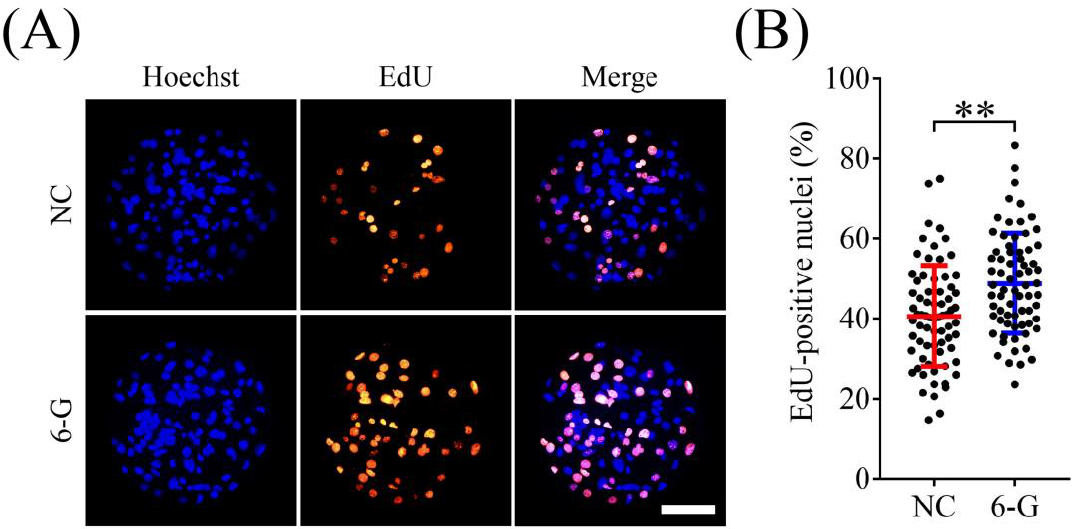
Figure 2. Effects of 6-gingerol (6-G) on cell proliferation in blastocysts. ( A ) Representative 5-ethynyl- 2′- deoxyuridine (EdU) staining images of embryos with or without 6-G at day 7. ( B ) Proportions of proliferating cells to total numbers of cells in embryos with or without 6-G treatment. R = 5. Bar = 100 μm. ** p < 0.01.